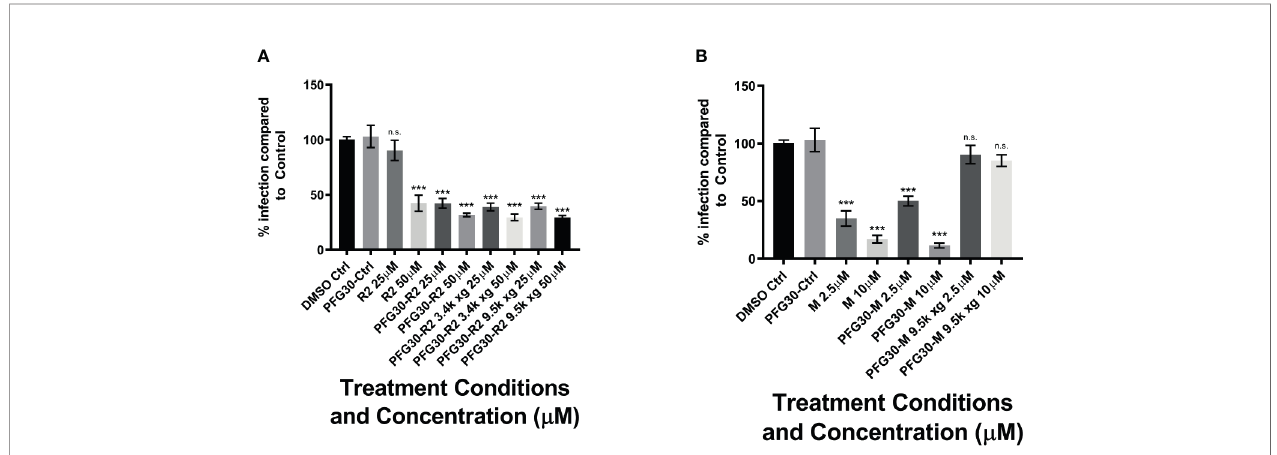
FIGURE 5 | Evaluation of PFG30 encapsulation ef fi ciency of Retro-2 and miltefosine through centrifugation separation of free and encapsulated drug. L. amazonensis- infected RAW264.7 macrophages were treated for 48 h with the following preparations: (A) Retro-2, PFG30 + Retro-2 or PFG30 + Retro-2 post-centrifugation; (B) miltefosine, PFG30 + miltefosine or PFG30 + miltefosine post-centrifugation. Cells were fi xed in 2% PFA in PBS. IFA ’ s were performed for detection of LAMP-1 and cell and parasite nuclei with DAPI. Statistical signi fi cance was determined by one-way ANOVA in GraphPad Prism 8 with the Holm- Š ídák posthoc test for multiple comparisons (n.s., not statistically signi fi cant, ***p-value < 0.001). Data were compiled from three biological experiments with at least two technical